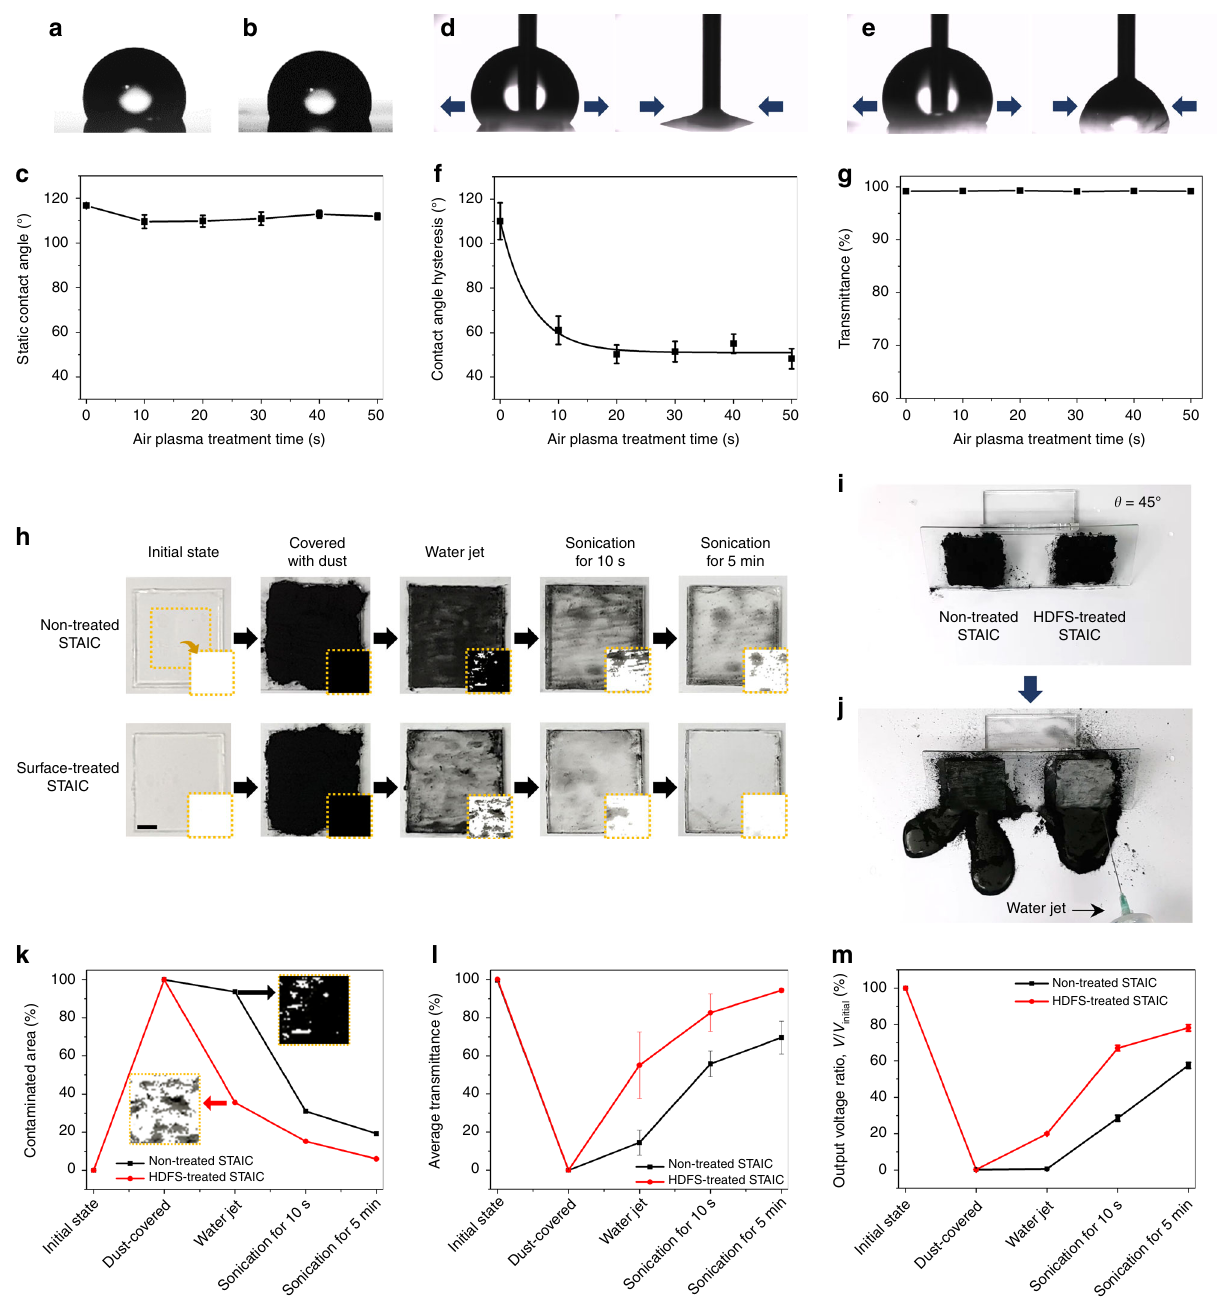
Fig. 3 Self-cleanability of transparent and attachable ionic communicators. Static contact angles were observed for a non-treated surfaces and b (heptadeca fl uoro-1,1,2,2-tetrahydrodecyl)trichlorosilane (HDFS) treated surfaces. c Static contact angles were investigated for various plasma time. Advancing and receding contact angles measured with deionized water on d non-treated surfaces and e HDFS-treated surfaces. f Contact angle hysteresis was greatly in fl uenced by HDFS treatments making the surface self-cleanable. g Transmittance of self-cleanable, transparent, and attachable ionic communicators (STAICs) for a green visible light (550 nm). h Self-cleanability of HDFS-treated STAICs was explored by cleaning surfaces which were contaminated by activated charcoal powders. i , j Demonstration of self-cleanability of STAICs. Dust on HDFS-treated STAIC was removed easily by a water jet. k Contaminated areas and l average transmittances at 550 nm were measured according to the processes. Ten points on STAICs were randomly explored to calculate the average transmittance. m Output voltages of STAICs were investigated according to the cleaning processes. All error bars in the fi gure represent standard error of the mean of the data (scale bar: 1 cm)